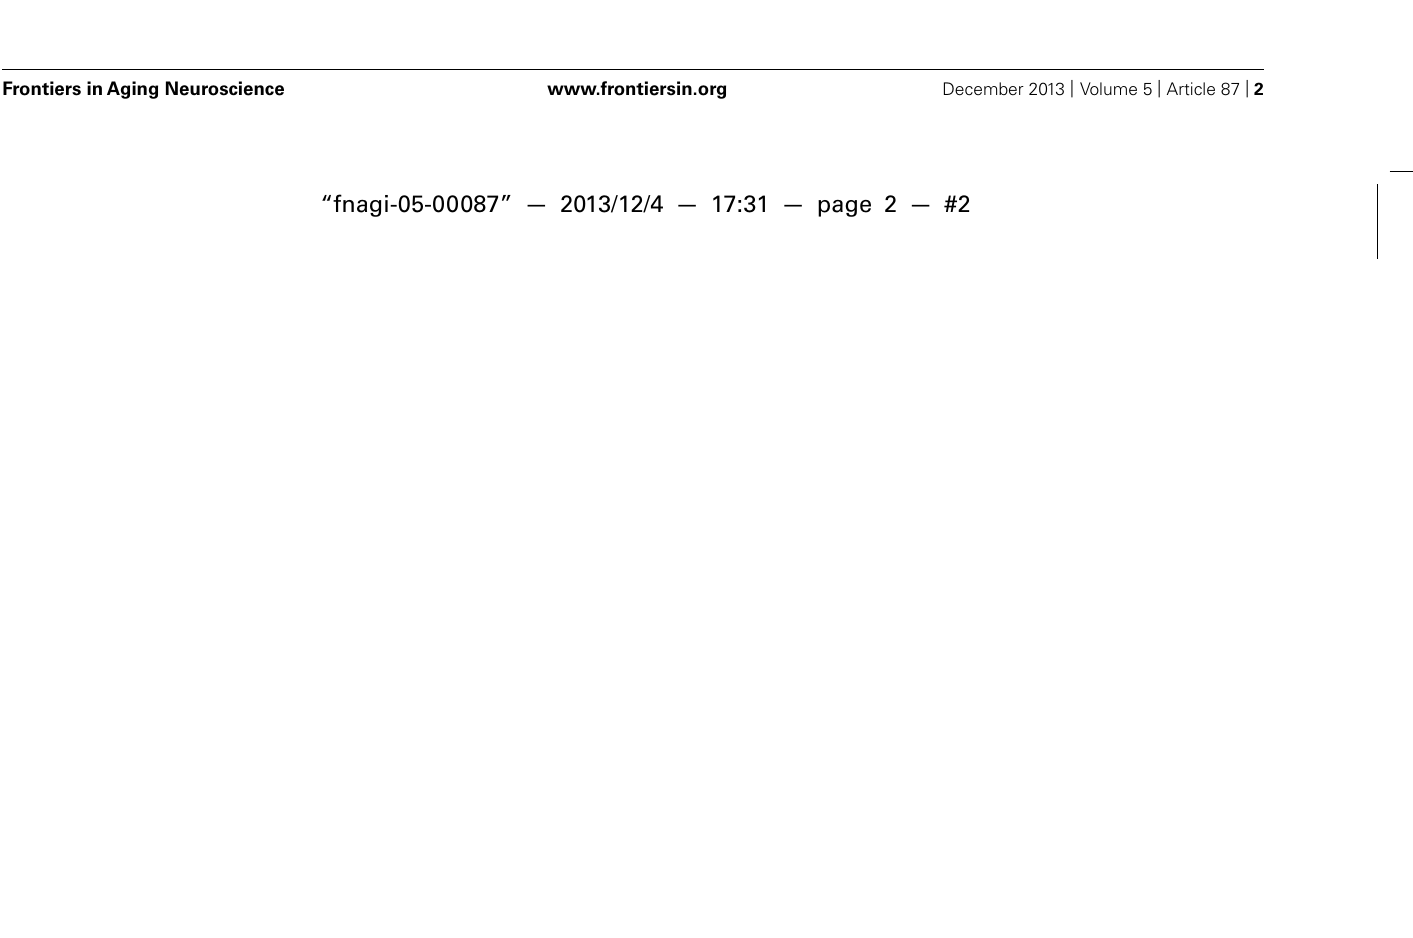
FIGURE 1 | Schematic representation of the experimental protocol with measures obtained at baseline, immediately after and 30 min after tDCS